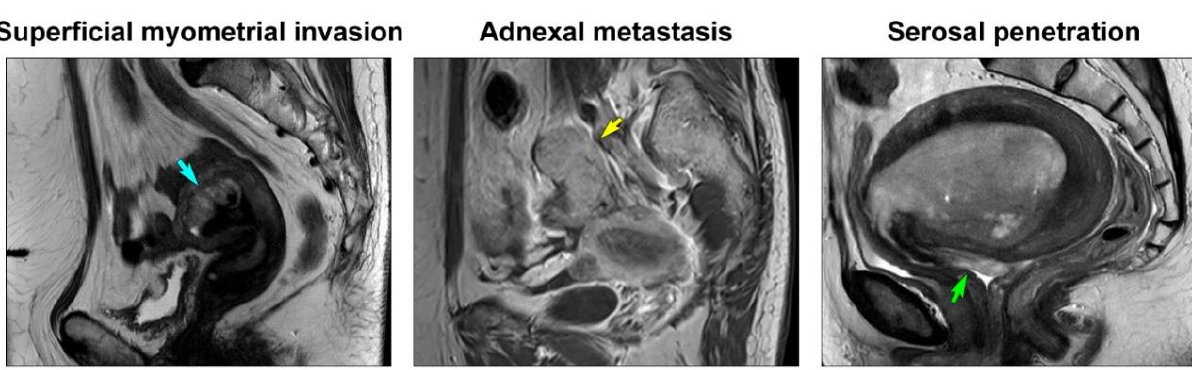
Figure 1. Preoperative magnetic resonance imaging findings. ( Left panel ) The tumor invades less than half of the myometrium (blue arrow). ( Middle panel ) The adnexa shows a metastatic tumor mass (yellow arrow). ( Right panel ) The tumor penetrates the uterine serosa (green arrow).